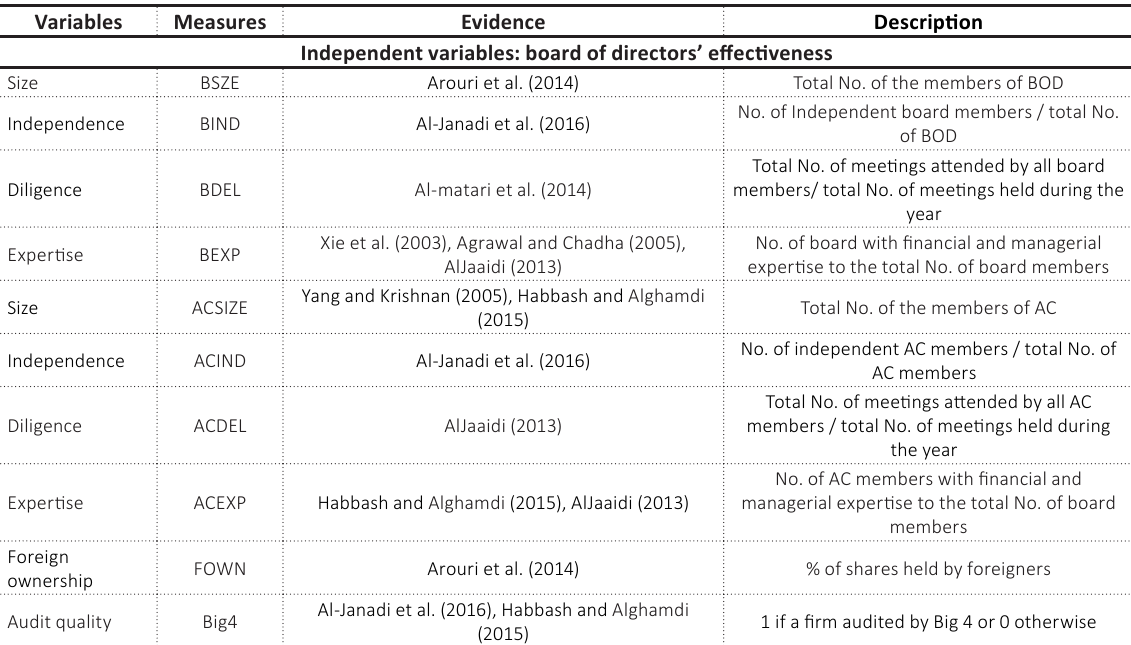
Table A1. Operational definition of